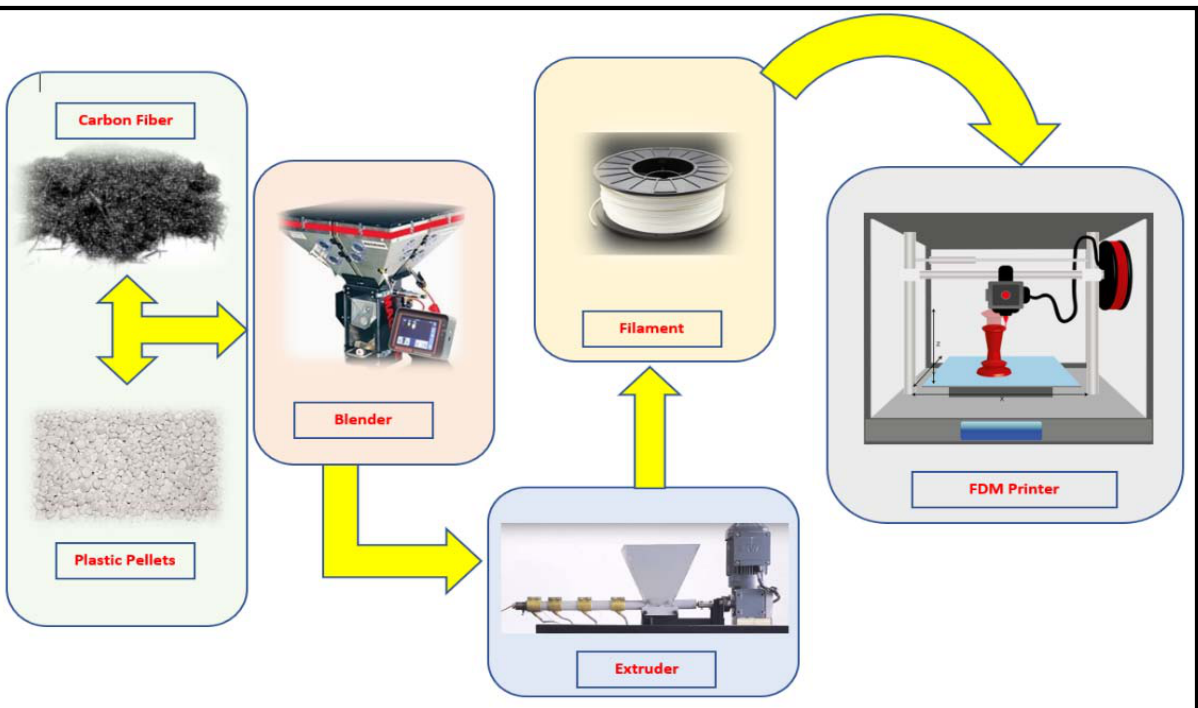
Figure 13. Schematic illustration of material flow in the first FRP printing strategy using a mixture of short fibers and polymer.